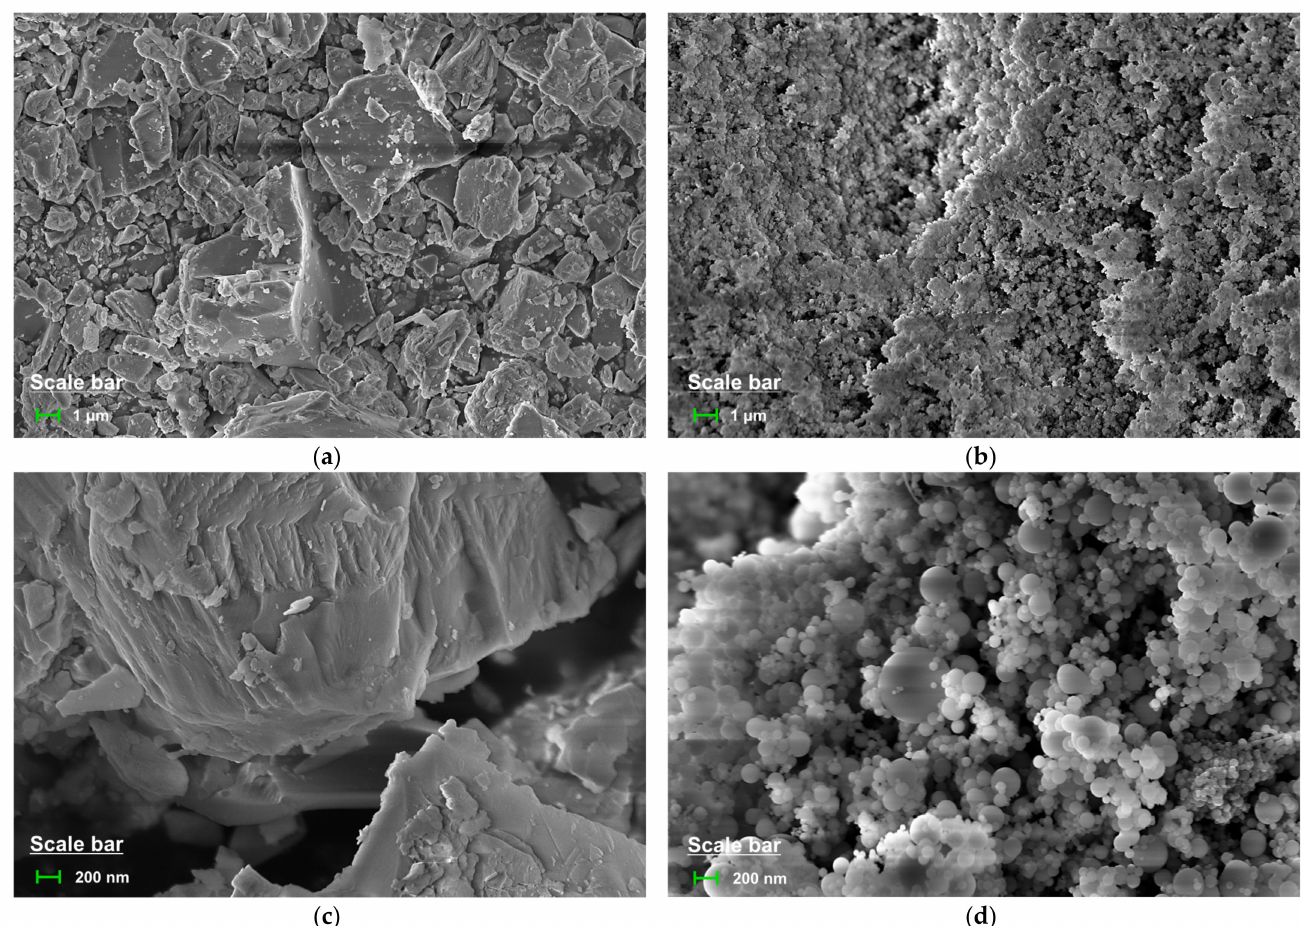
Figure 1. SEM images of binders: ( a ) Cement (magnification of 10,000 × ); ( b ) Silica fume (magnification of 10,000 × ); ( c ) Cement (magnification of 50,000 × ); ( d ) Silica fume (magnification of 50,000 × ).